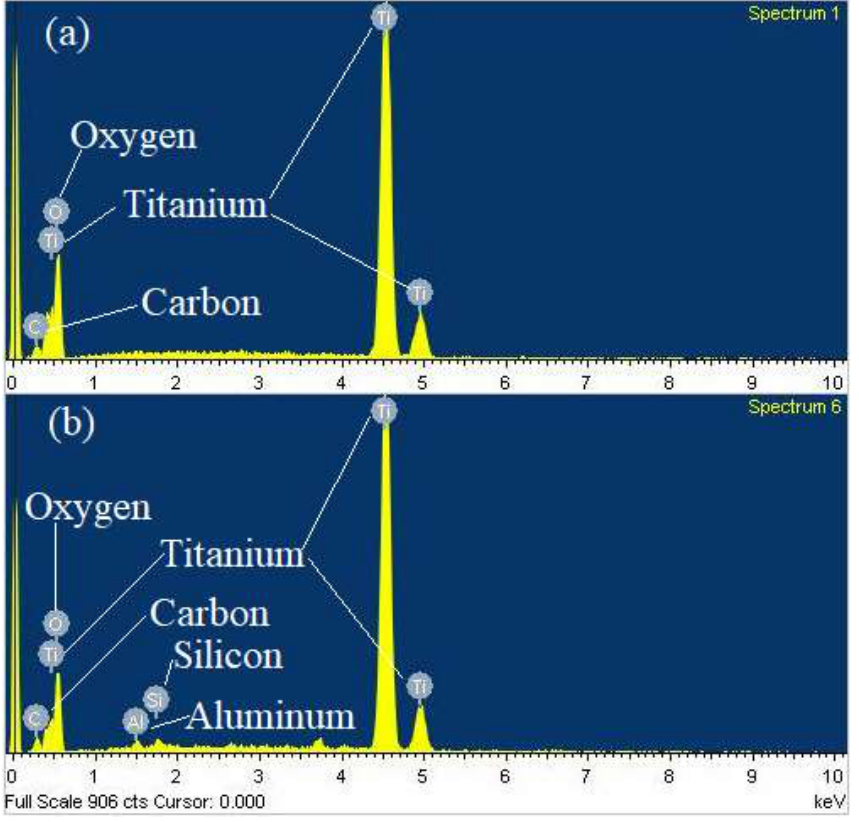
Figure 4. EDS spectra of ( a ) C-TiO 2 and ( b ) C-TiO 2 -CFA.